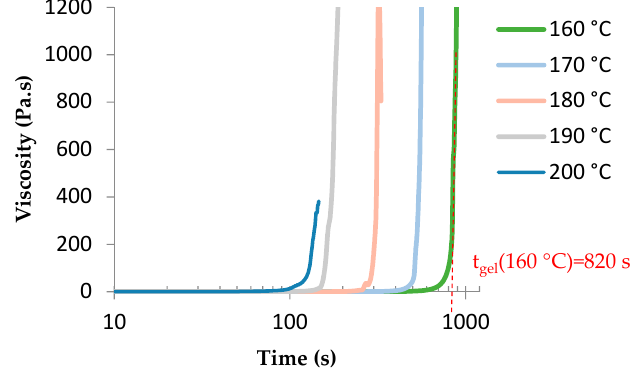
Figure 10. Determination of the gel time of TETM/DDS formulation at various temperatures.